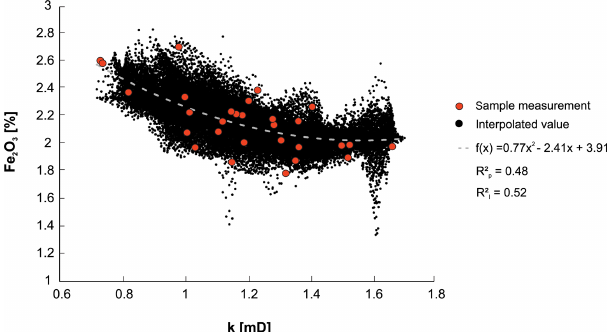
Figure 14. Regression analysis of the relationship between intrinsic permeability and mass fraction of Fe 2 O 3 in the interpolated scalar fields of the rock cube OSB2_c. R 2 p is the coefficient of determina- tion for the plug measurements, and R 2 is the coefficient of deter- i mination for the interpolated